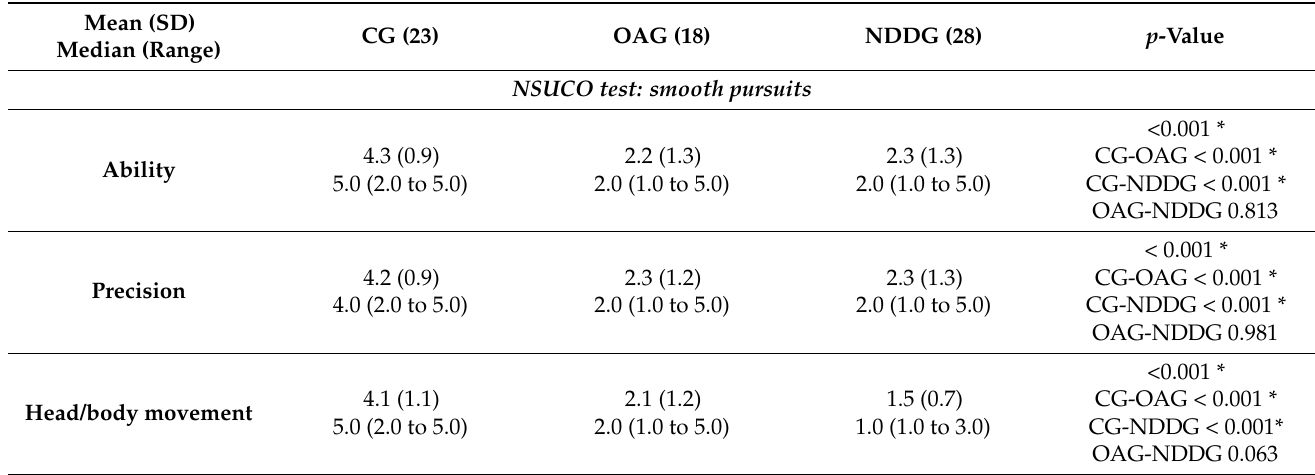
Table 6. Summary of the results of the oculomotor examination in the three groups of children evaluated: CG, control group; OAG, group of children with oculomotor abnormalities; NDDG, group of children with neurodevelopmental